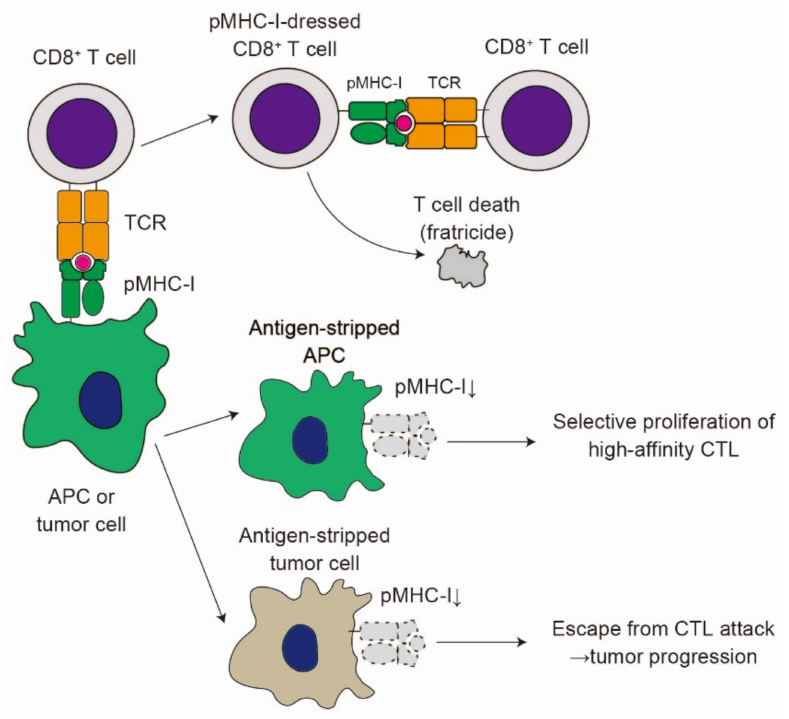
Figure 4. The impact of trogocytosis on CD8 + T cell responses. Upon formation of immunological synapse, CD8 + T cells acquire pMHC-I complexes from APCs or tumor cells. pMHC-I-dressed CD8 + T cells are susceptible to attack from other CD8 + T cells, resulting in cell lysis (fratricide). Trogocytosis reduces the expression of pMHC-I on APCs (antigen stripping). Antigen stripping in APCs favors the selective proliferation of high-affinity CTL. On the contrary, antigen stripping in tumor cells contributes to the escape from CTL attack, leading to tumor